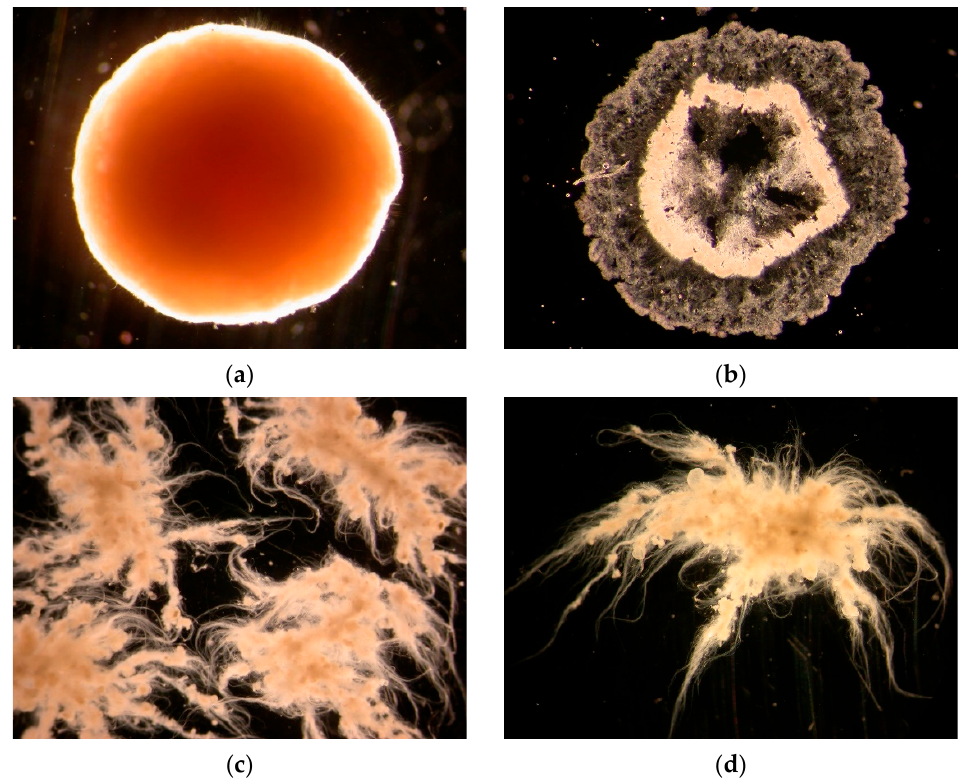
Figure 5. Large granules and broken granules. ( a ) A large granule from SBR1; ( b ) the cross section of a large granule cut by freezing microtome; ( c ) a broken granule torn by a tweezer; ( d ) a piece of torn cluster from a granule. Scale bar = 1 mm.